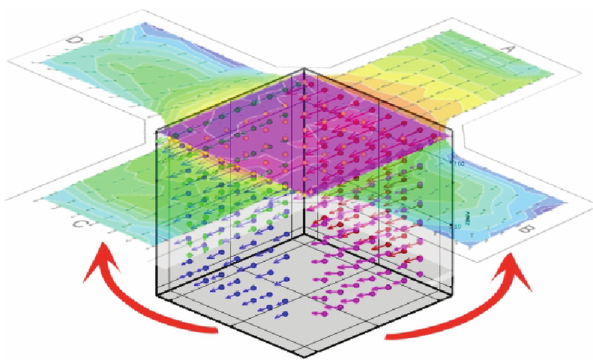
Figure 6: The transformation of the measured three-dimensional grid to an horizontal